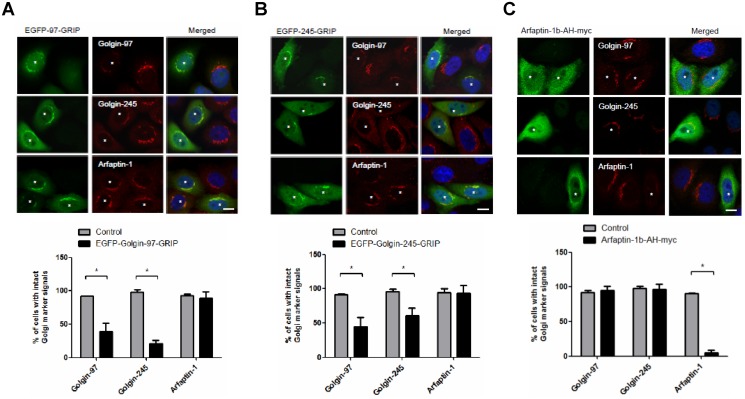
Exogenous expression of the EGFP-GRIP domain does not induce the dissociation of arfaptin-1 from the Golgi apparatus.HeLa cells were transfected with EGFP-97-GRIP (A), EGFP-245-GRIP (B) or arfaptin-1b-AH-myc (C) for 48 h, and the cells were then stained with anti-myc and anti-golgin antibodies (anti-golgin-97, anti-golgin-245 and anti-arfaptin-1). The percentage of EGFP-GRIP- or arfaptin-1b-AH-myc-expressing cells (n>50 for each experiment) with intact Golgi marker signals was quantified, and the data are presented as the means±SDs; p<0.05 indicates significance, as determined by the unpaired Student’s t test. Scale bars, 10 μm. Asterisks indicate EGFP-97-GRIP- (A), EGFP-245-GRIP- (B) or arfaptin-1-AH-myc-expressing (C) cells. It is notable that the epitope of polyclonal goat anti-arfaptin-1 (Santa Cruz, sc19246) that was used in the current study is near the N terminus of arfaptin-1 (1a and 1b); therefore, it could not be used to detect arfaptin-1b-AH-myc because the AH domain is located in the C-terminal region of afaptin-1.